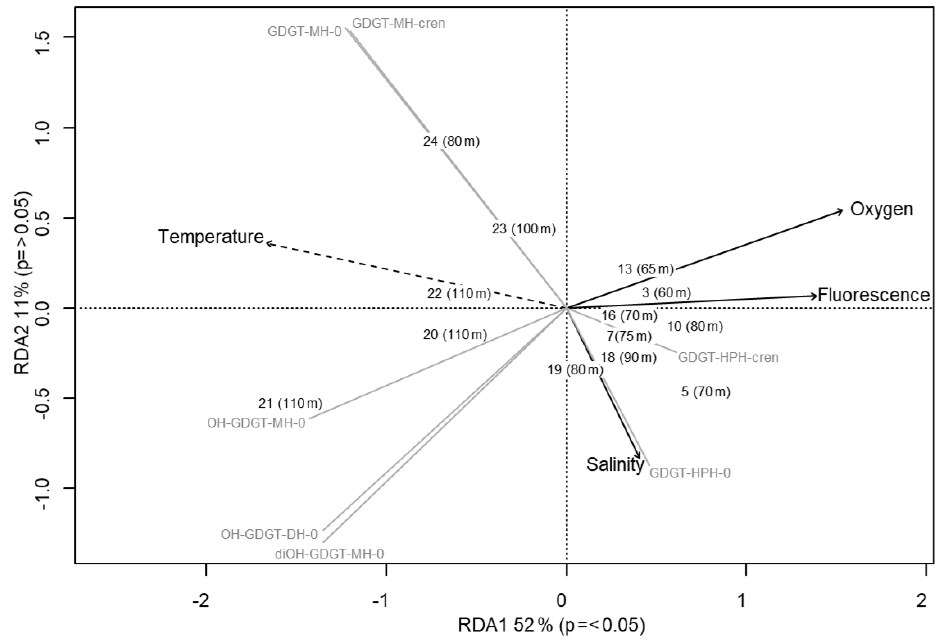
Figure 5. Redundancy analysis triplot for Scotia Sea sample set showing samples with depths, biomarker response variables (grey lines), and explanatory variables (black with dashed lines indicating statistical